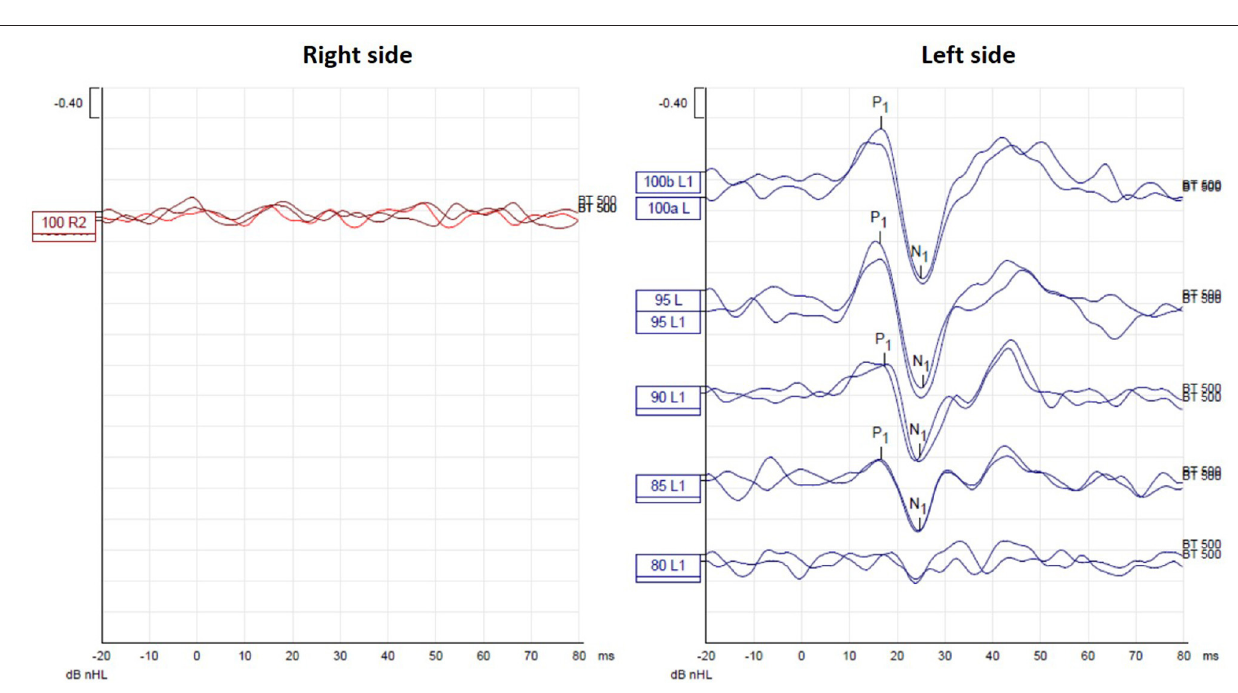
FIGURE 3 | cVEMP testing showed absence of P1-N1 complex for the right side, while it was present for the left side. This pattern was confirmed with test-rest on one